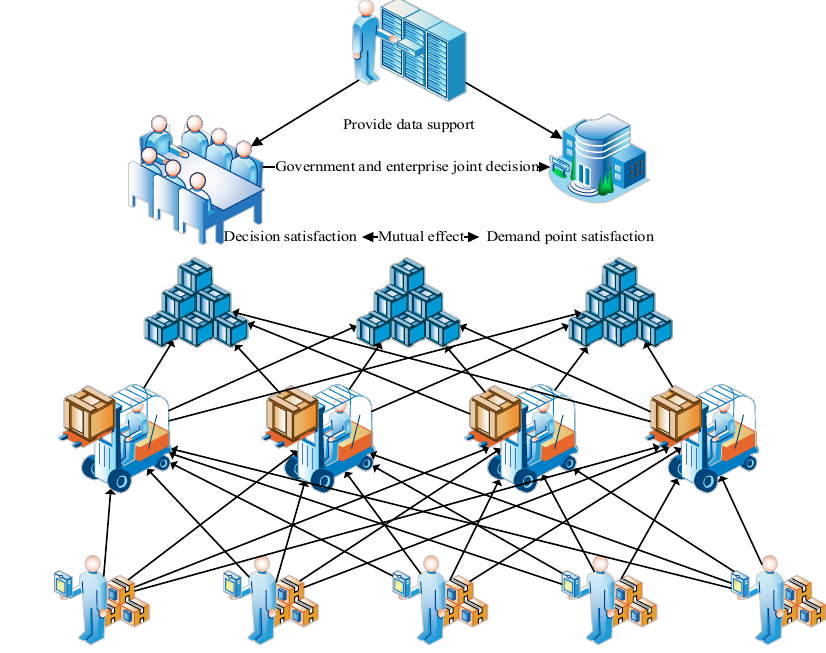
Figure 1. Problem Description Diagram.